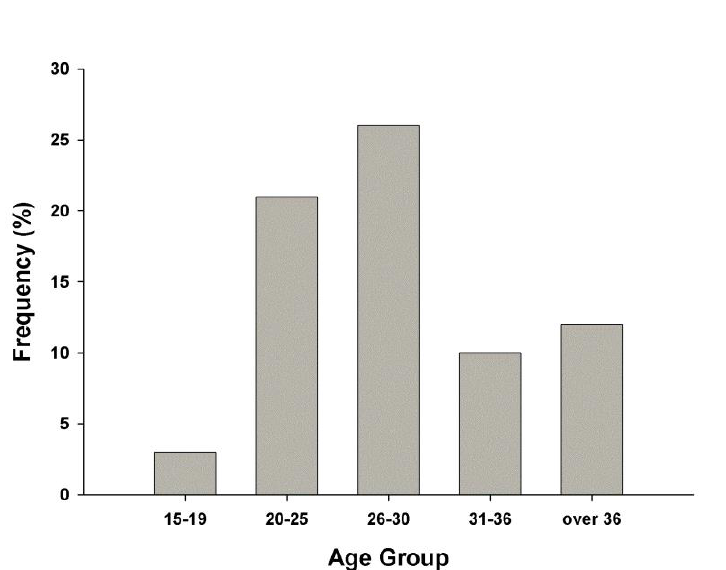
Figure 1. Age distribution of the injured